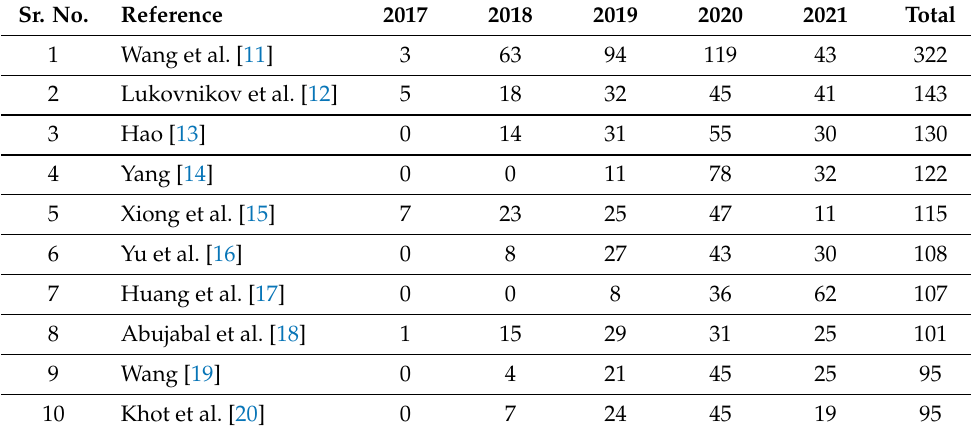
Table 3. Highly cited publications in the last five years (SCOPUS).